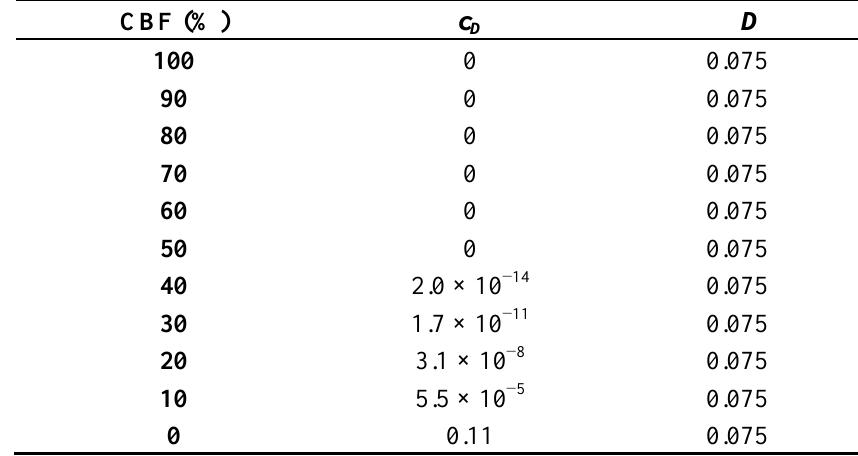
Table 1. c and λ calculated by Equations (6) and (7), corresponding to decade D D decrements in cerebral blood flow